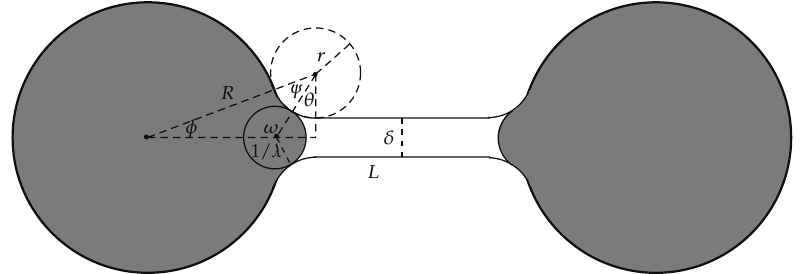
Figure 6: Dumbbell with angles φ , θ , ω , and ψ